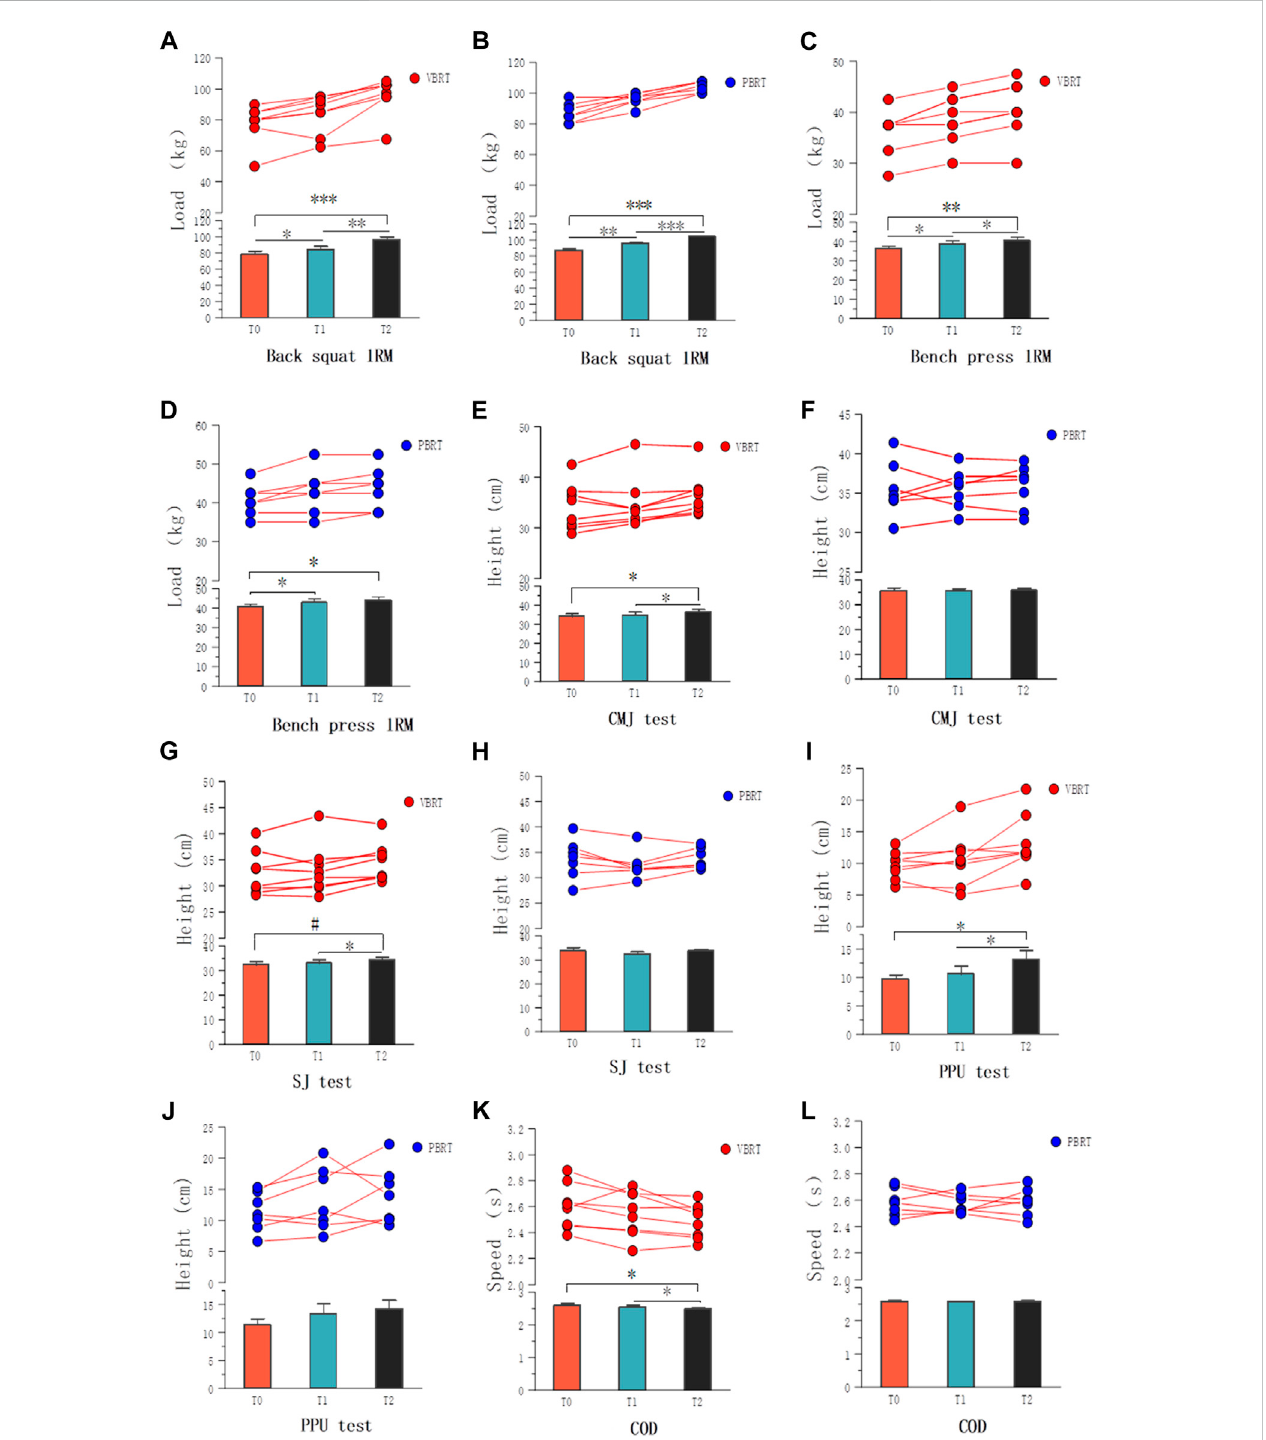
FIGURE 6 Mean changes in back squat 1RM (A,B) , bench press 1RM (C,D) , CMJ (E,F) , SJ (G,H) , PPU (I,J) and COD (K,L) by group (VBRT-PBRT, respectively) after 3 and 6 weeks of training. *Signi fi cant difference in paired t-test; # Signi fi cant difference in Wilcoxon rank. RM: repetition maximum; CMJ: countermovement jump; SJ: Static squat jump test; PPU test: plyometric push-up test; COD: 505 change of direction performance; T0: baseline test; T1: intermediate assessments of 3 weeks; T2: post-intervention